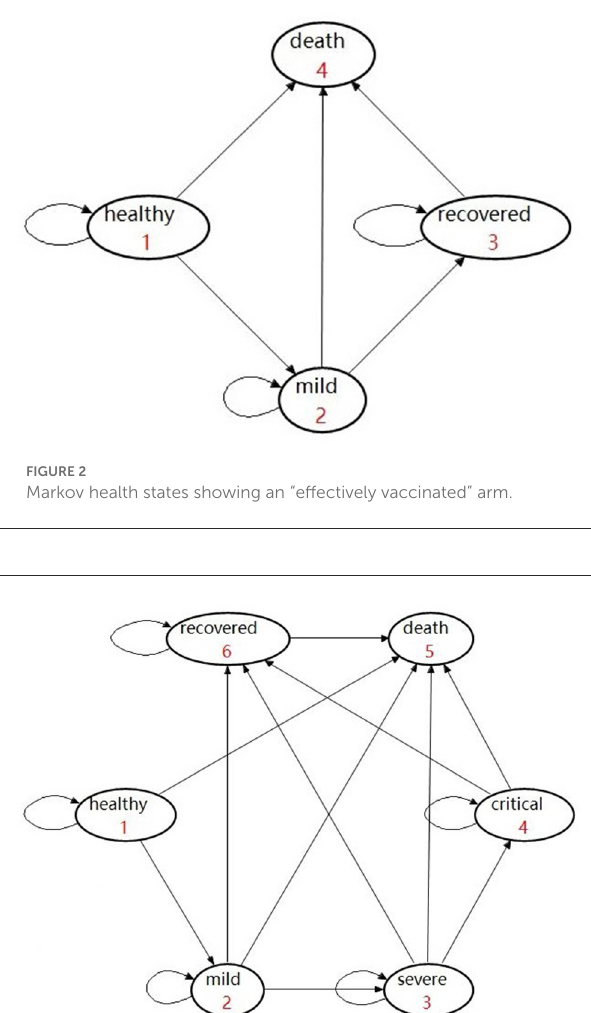
and published in a credible peer-reviewed journal, (2) all the patients in the trial finally recovered, and (3) none of them deteriorated to critical or death (due to COVID). The latter two facts are quite consistent with our assumption that it would be impossible for effectively vaccinated groups to deteriorate from “healthy” to “severe” and “critical”. Details related to the